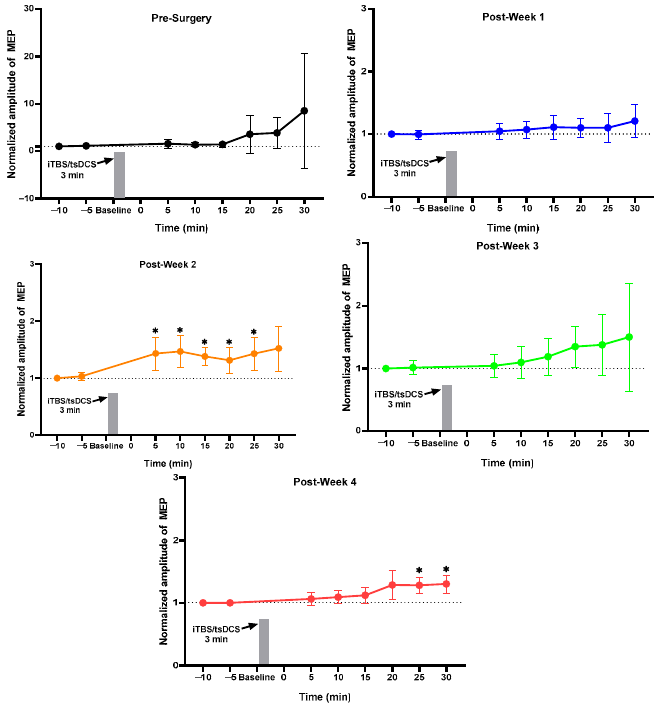
Figure 2. Sham ( n = 4): Sham group. Pre-Surgery, MEP before surgery; Post-Week 1, MEP after surgery and sham intervention of one week; Post-Week 2, MEP after two weeks of intervention; Post-Week 3, MEP after three weeks of intervention; Post-Week 4, MEP after four weeks of intervention.